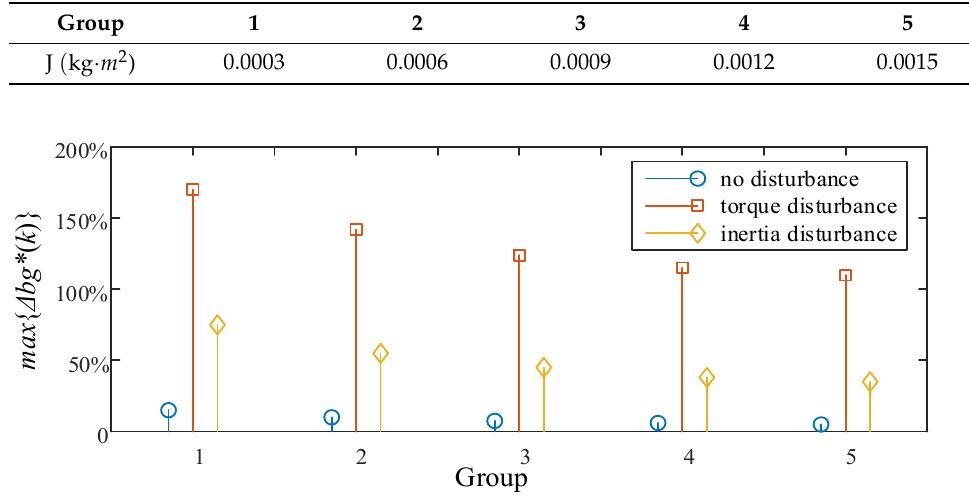
Figure 5. Experimental results of the different disturbance types.